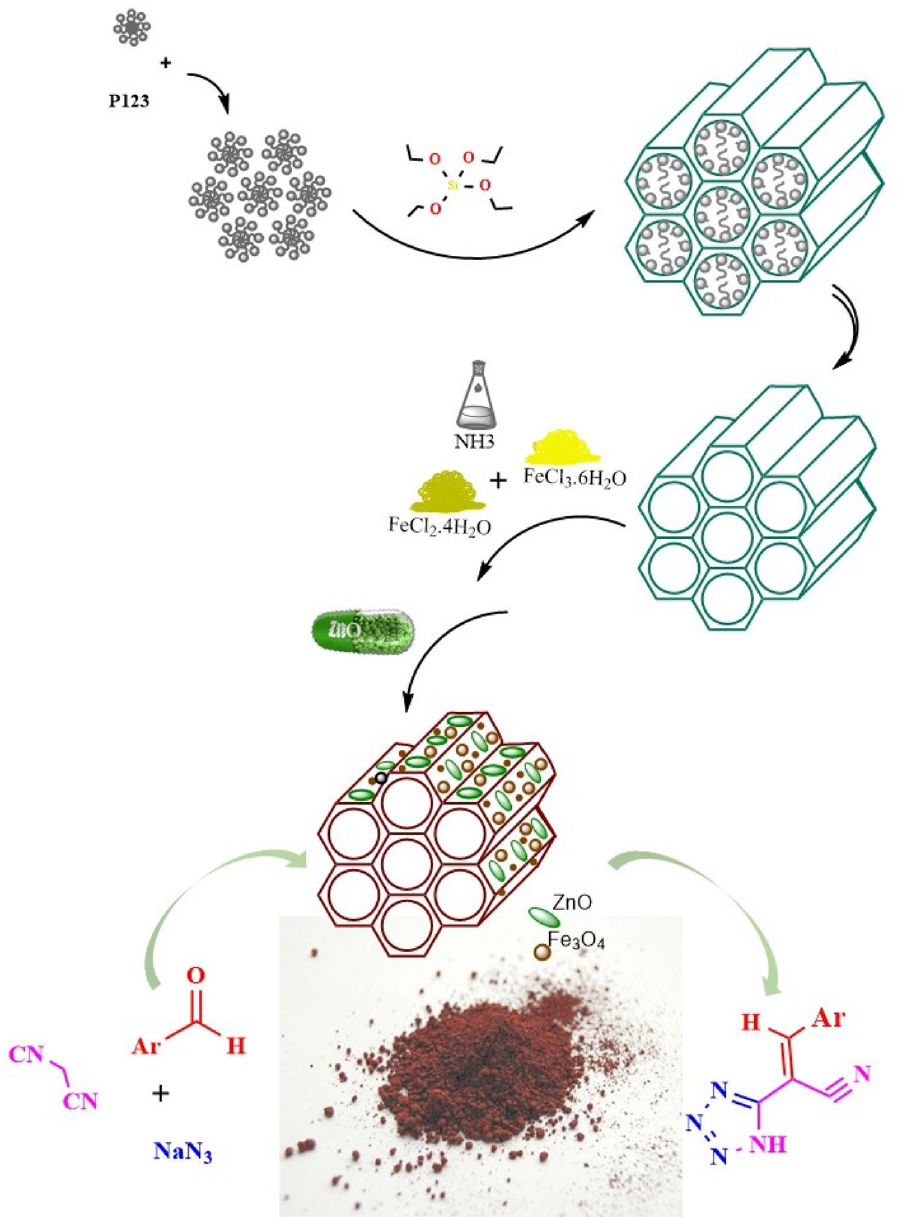
Figure 2. Schematic preparation of the Fe 3 O 4 @PMO-ICS–ZnO ( 1 ) catalyst and its application in the synthesis of tetrazoles derivatives 5a–o